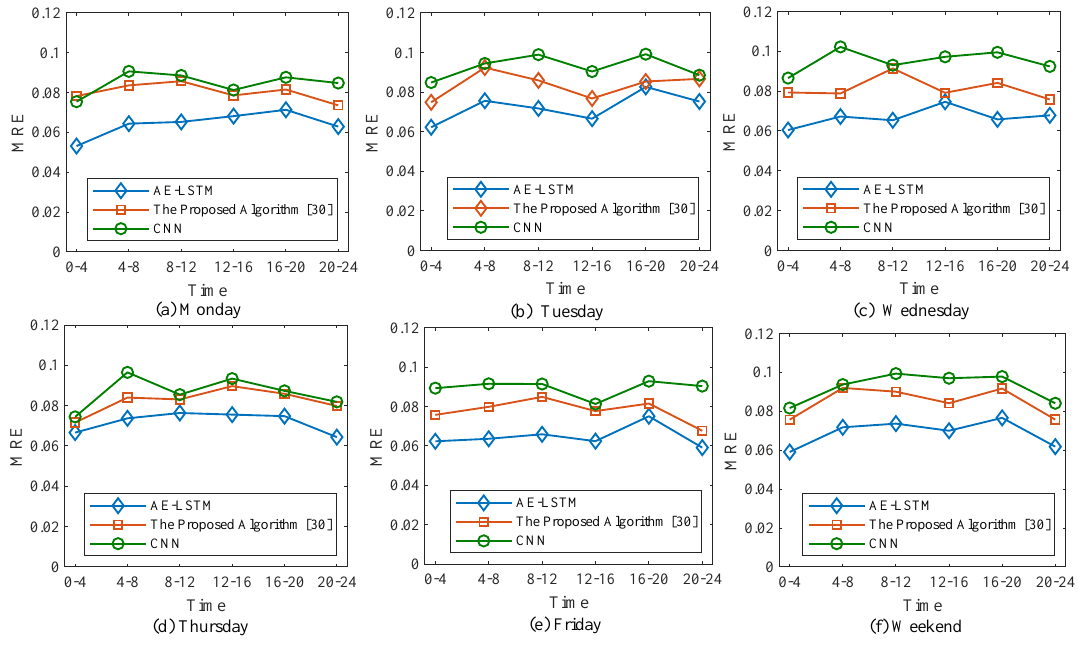
Figure 8. MRE statistics of the three prediction algorithms. We calculated the MAE of traffic flow prediction for six